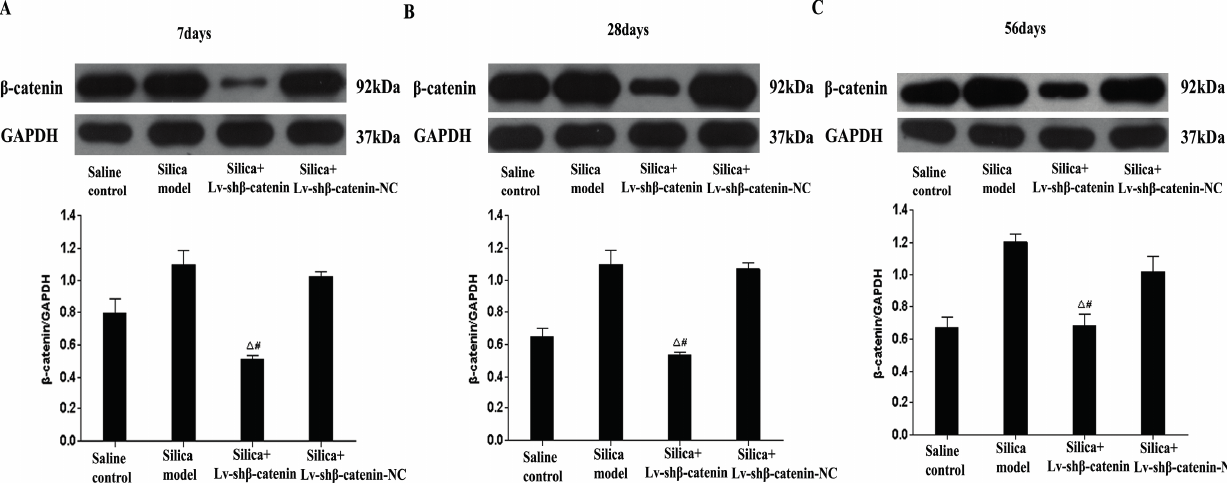
( B ) At 28 days and ( C ) 56 days after the instillation. Data are expressed as mean ± SE (n = 3). Δ p < 0.05, compared to the silica group; # p < 0.05, compared to the silica + Lv-sh β -catenin-NC